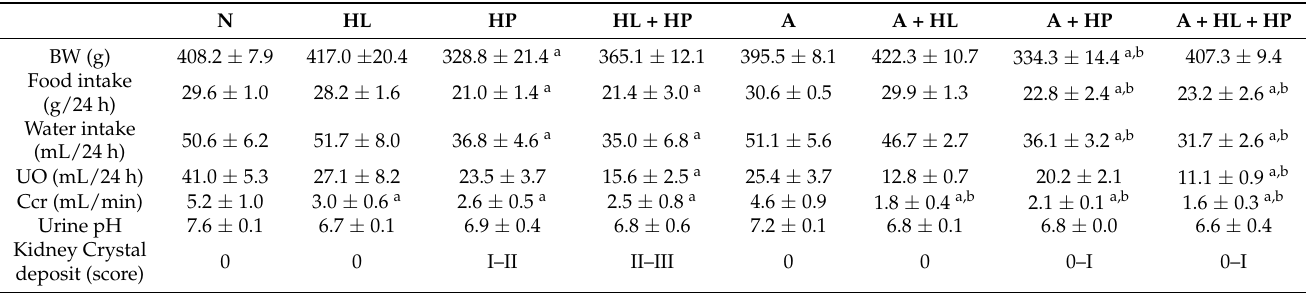
Table 1. Summary of body data, urinary chemistry, and crystal